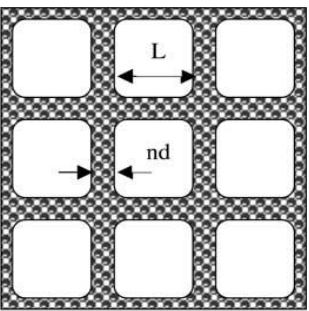
Figure 3. Mamunya geometrical model of the framework structure of the segregated polymer system. Reprinted from Ref. [32]. Model parameters: D = L + nd , where L is the size of an excluded volume of the polymer, n is the number of layers of the conductive particles in the framework, D — size of the polymer particles, d — size of the filler particles.